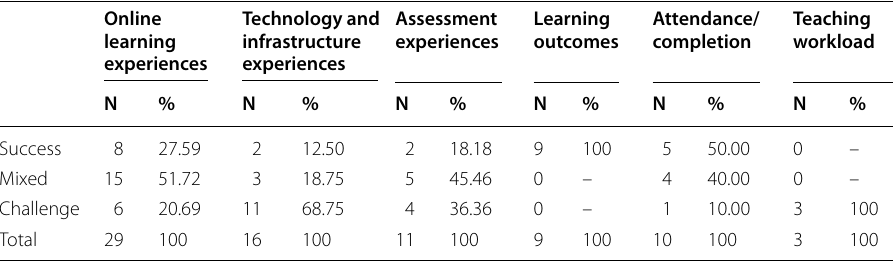
Table 2 Success and challenges of shifting